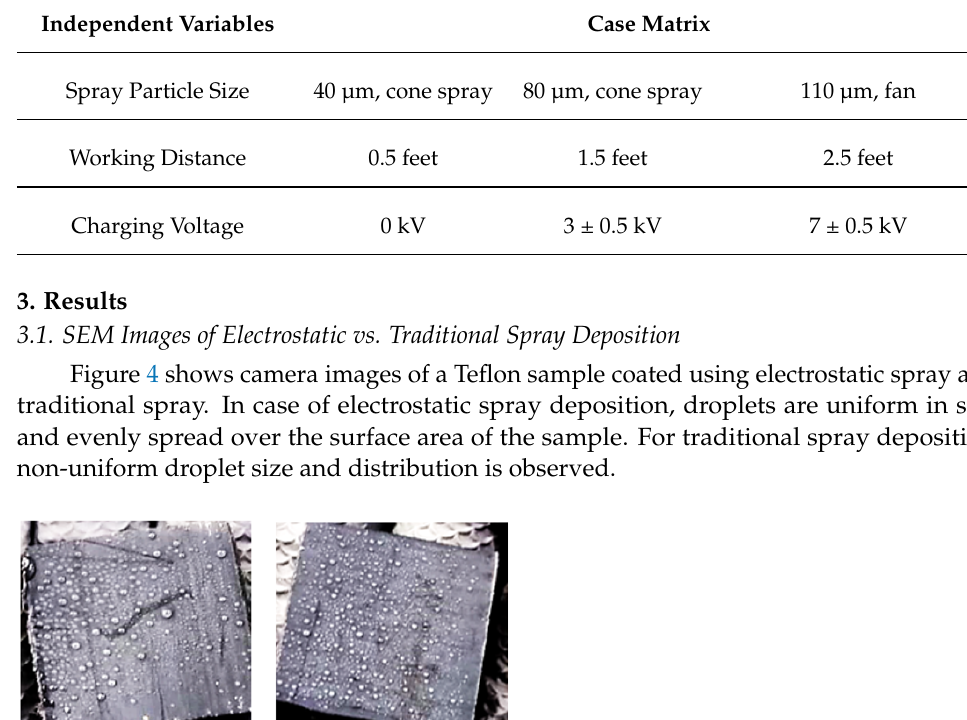
Table 2. Test matrix with varying voltage (V), nozzle spray size (ND) and working distance (WD). Independent Variables